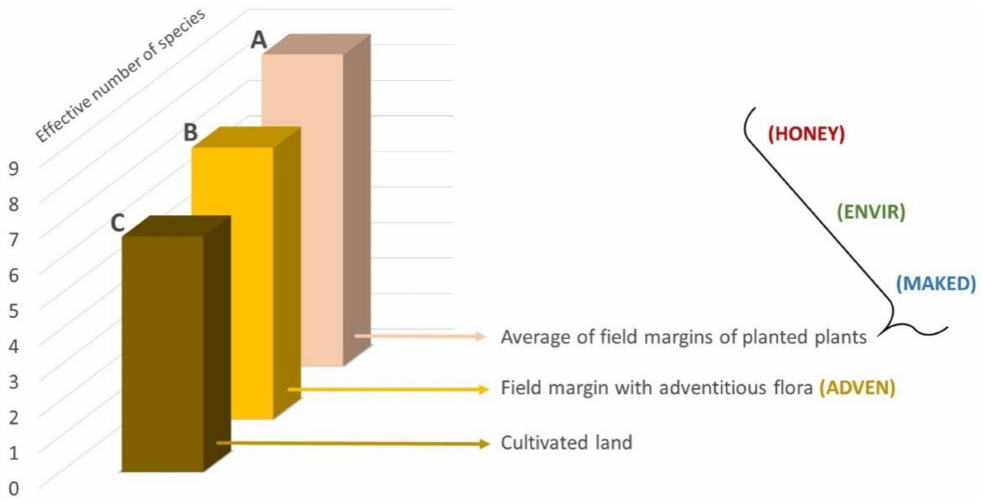
Figure 4. Relationship between the existing biodiversity in sown MFM, in MFM of spontaneous flora and in attached crops, on a general scale. Different letters (A, B, C) show significant differences in the analysis of variance obtained through the LSD test ( p ≤